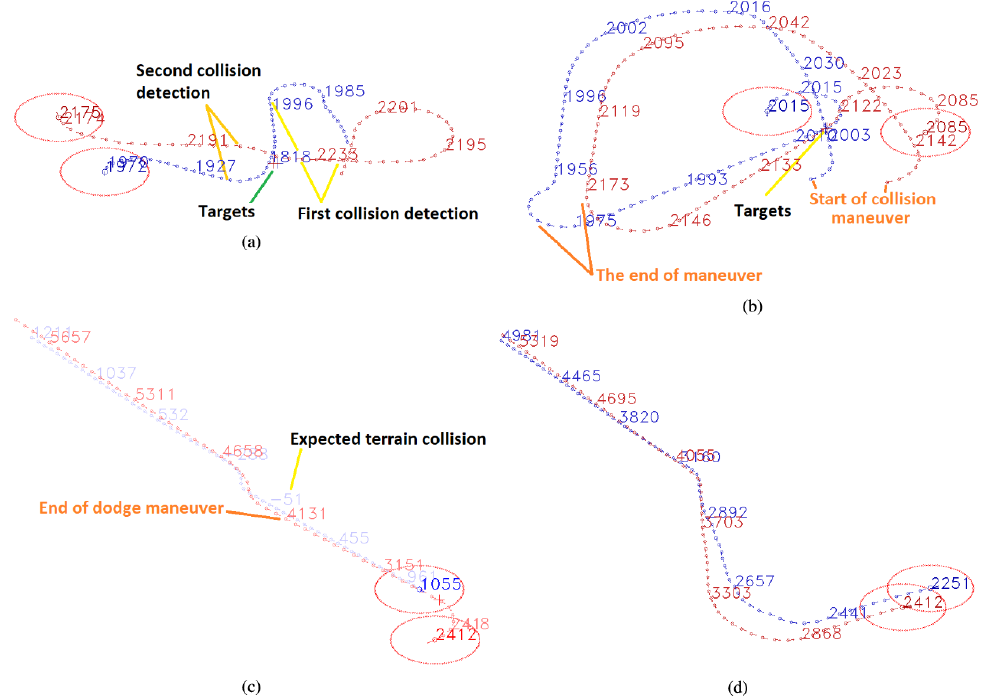
Figure 10. Output images from the simulation. ( a ) Dodge maneuvers of two crossing airplanes. ( b ) Dodge maneuvers of two semi-parallel airplanes. ( c ) Straight route with spherical safety zone— original algorithm. ( d ) Straight route with limited vertical movement and spheroid safety